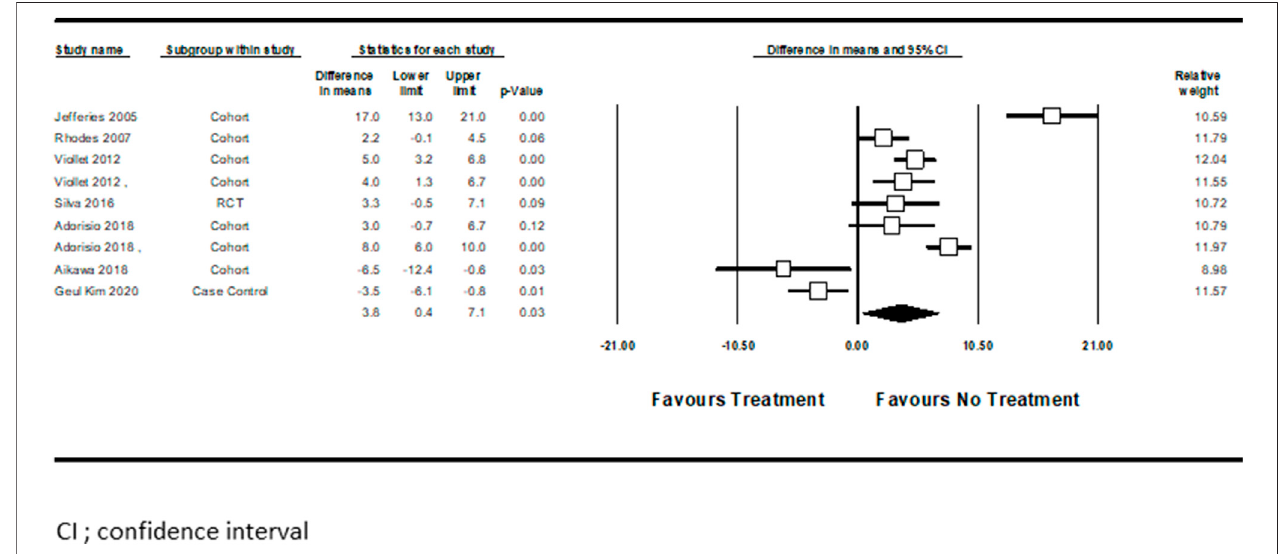
FIGURE 2 | The differences in means for LVEF (%) following HF treatment versus control.